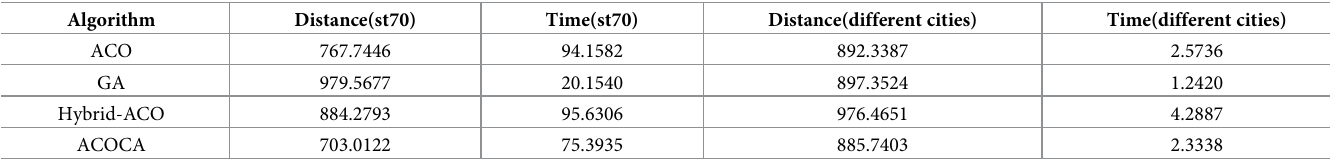
Table 4. The results of